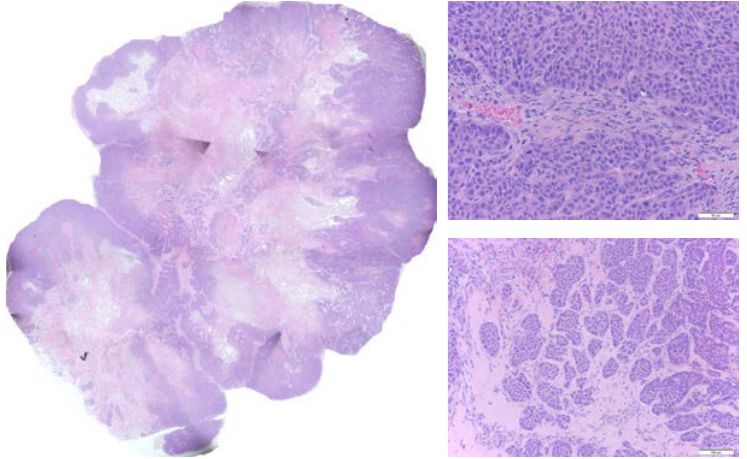
Fig. 6. H&E staining for the p53 (cid:1) = (cid:1) tumor in Fig. 3. Photo-stitched whole tissue section (L), typical tumor rim (top right, 40X) and typical tumor center (bottom right,